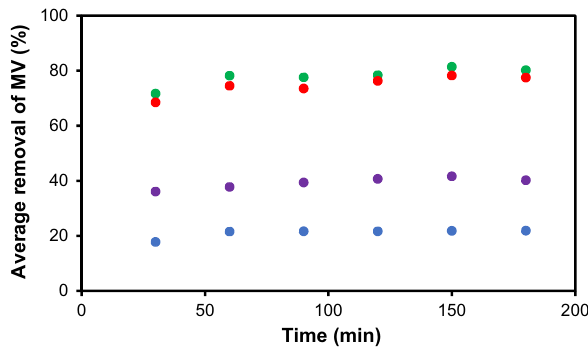
Fig. 1 The effect of contact time on adsorption MV2B on IA at different dye concentrations [50 mg L −1 ( ), 100 mg L −1 ( ), 200 mg L −1 ( ) and 500 mg L −1 (